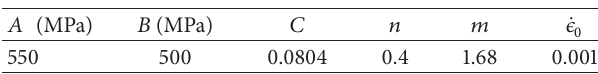
Table 2: Johnson-Cook parameters.